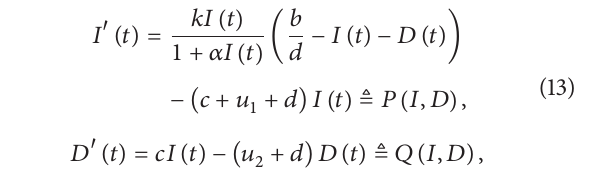
That is, if the initial value (𝑆(0), 𝐼(0), 𝐷(0)) ∈ Λ , then the solutions of (6) are in the set Λ , for all 𝑡 ≥ 0